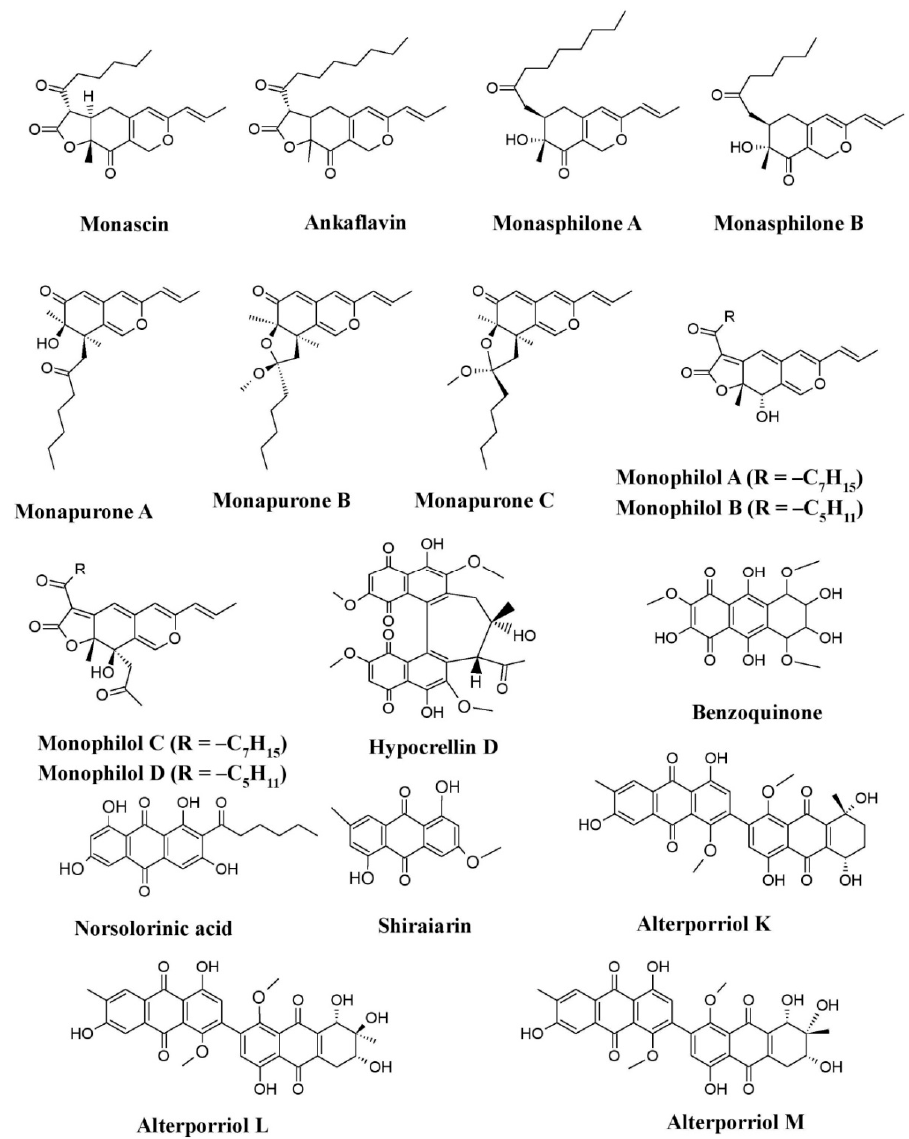
Figure 12. Pigments from different taxonomic groups of fungi having promising anticancer or antitumor potential, re-drawn from [32,56–58,62,68,88,89,113,204,205].